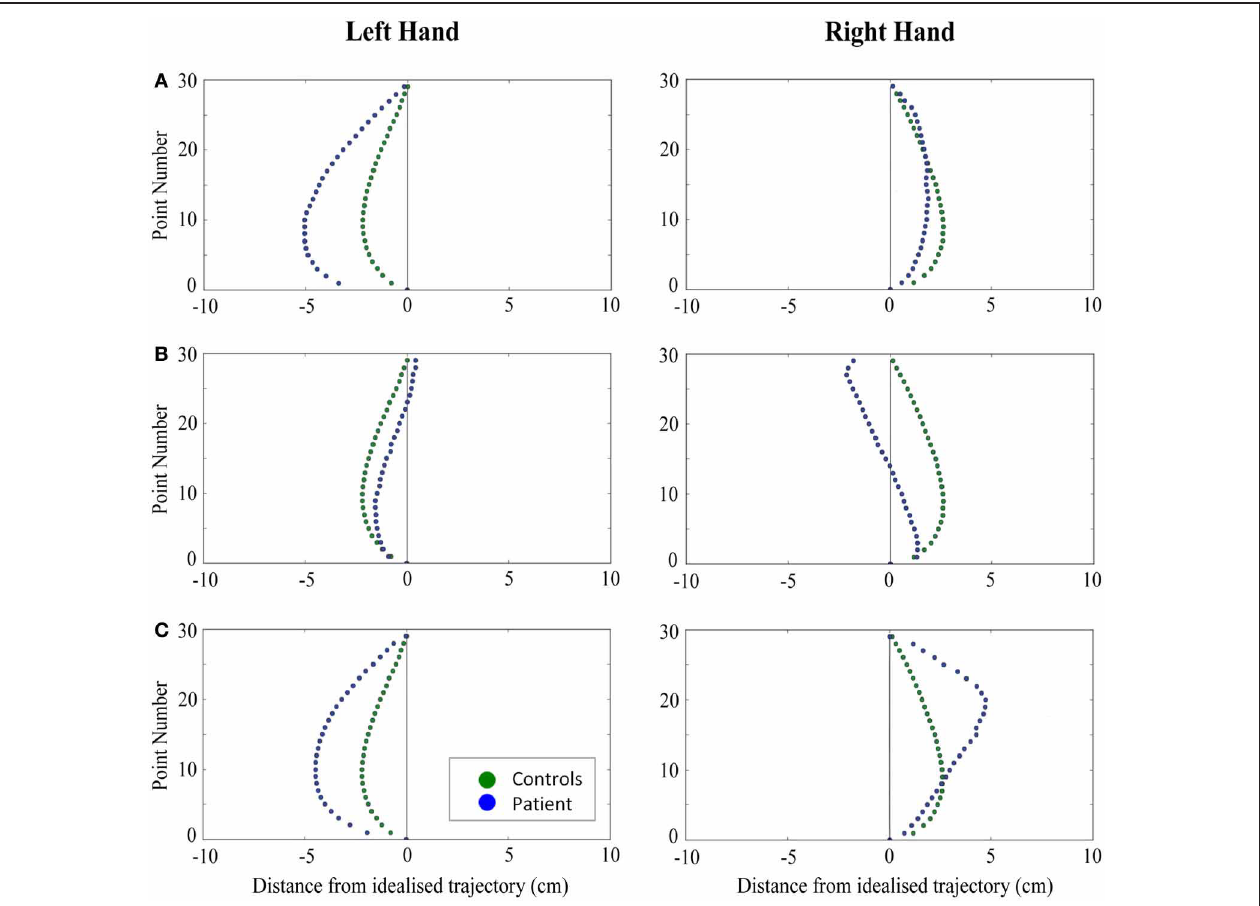
FIGURE 5 | A comparison of standardized reach paths for controls vs. patients—(A): patient RB, (B): patient SS, and (C): patient AP—when grasping ipsilaterally presented objects with both the right and left hands in Experiment 2.